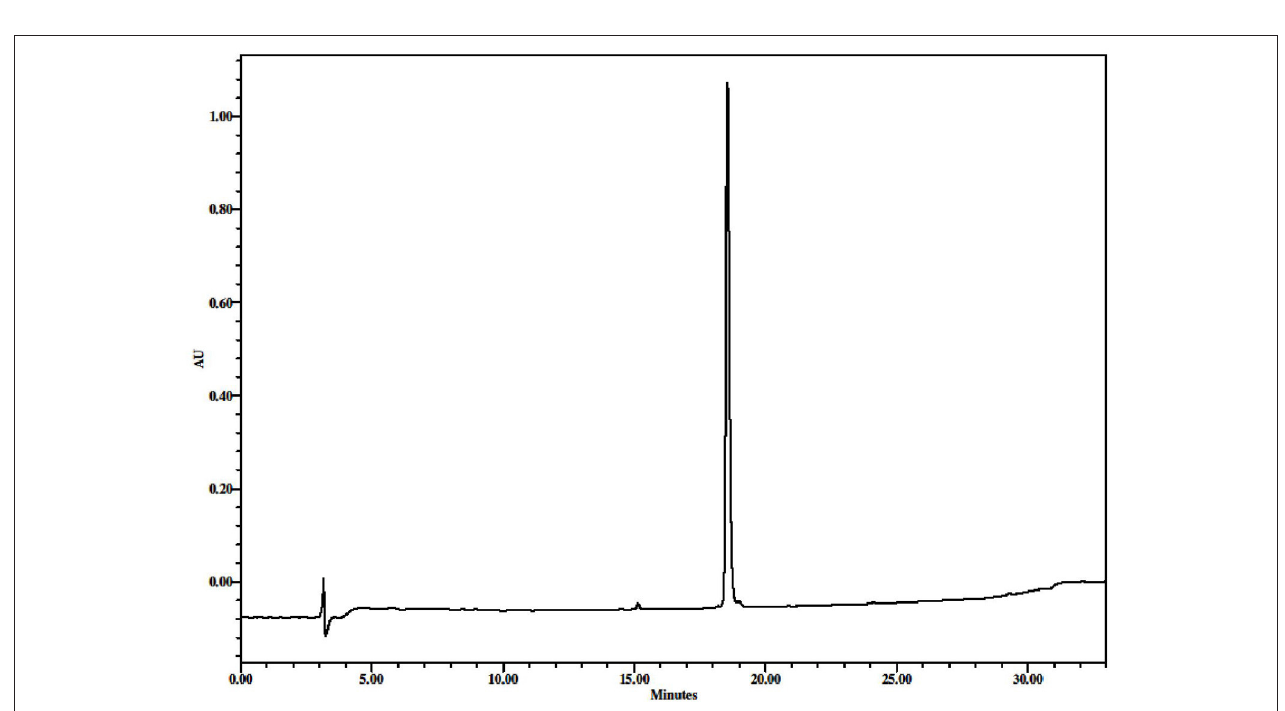
FIGURE 3 | RP-HPLC profile of the purified N -Z-DEVD-aLuc (8) , 5–80% B in 25 + 3min up to 100% B + 5min in 100% B, t R = 18.555min.